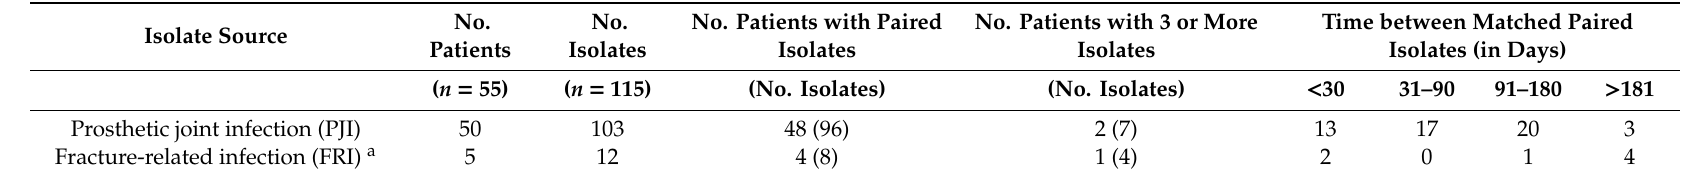
Table 1. Summary of the multiple patient matched infection isolates used in the